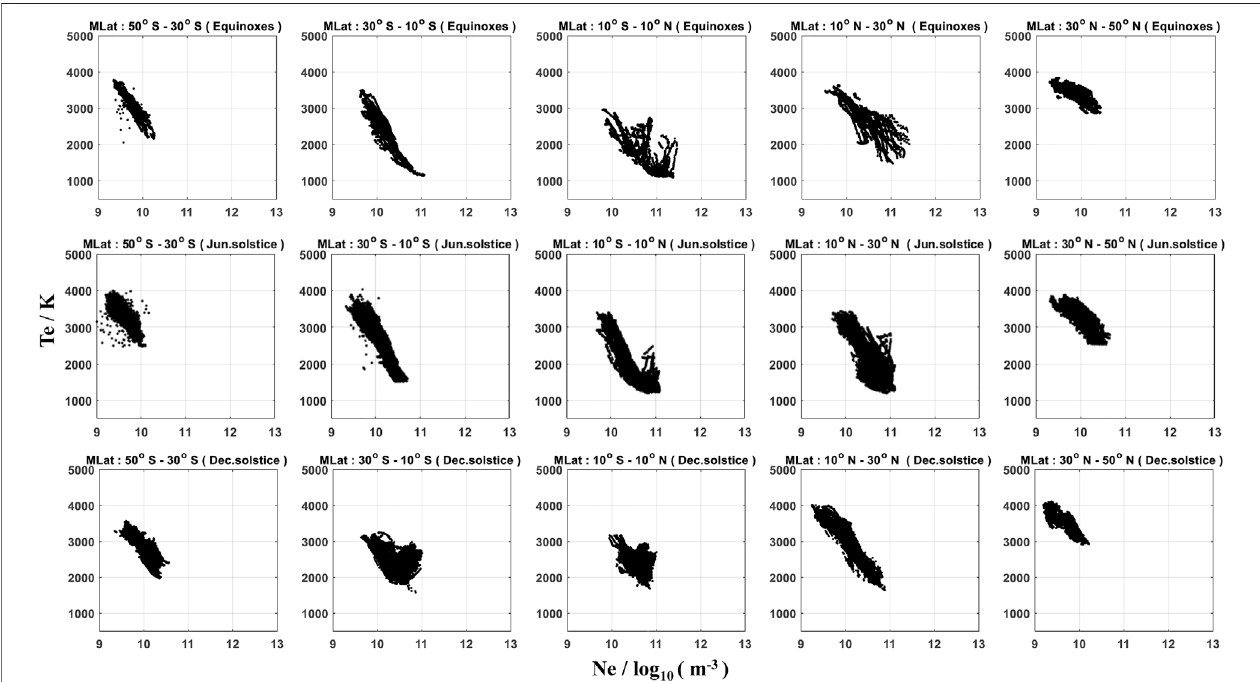
FIGURE 5 | Correlation of Ne and Te from CSES during different MLat ranges. From top to bottom, correspond to Equinoxes, June solstice, and December solstice. From left to right, the MLat range corresponds to 50 ° S - 30 ° S, 30 ° S - 10 ° S, 10 ° S - 10 ° N, 10 ° N - 30 ° N, 30 ° N- 50 ° N respectively.